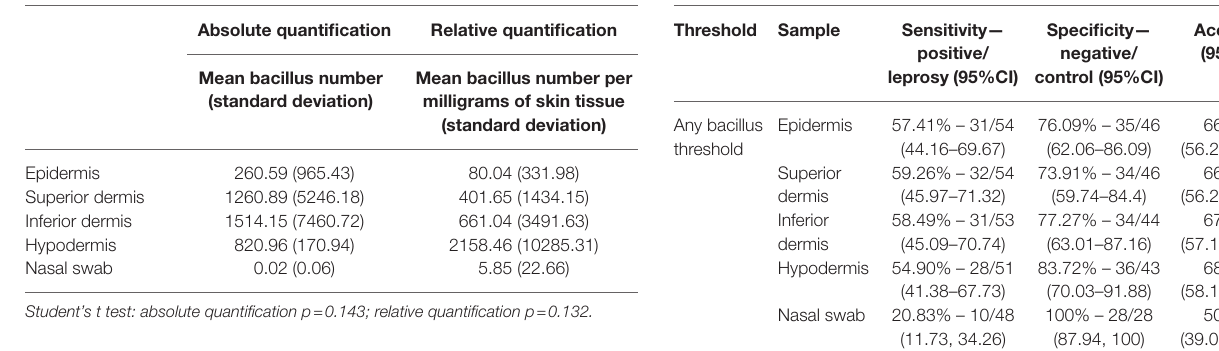
TABLE 1 | Mean absolute and relative quantification results of the included